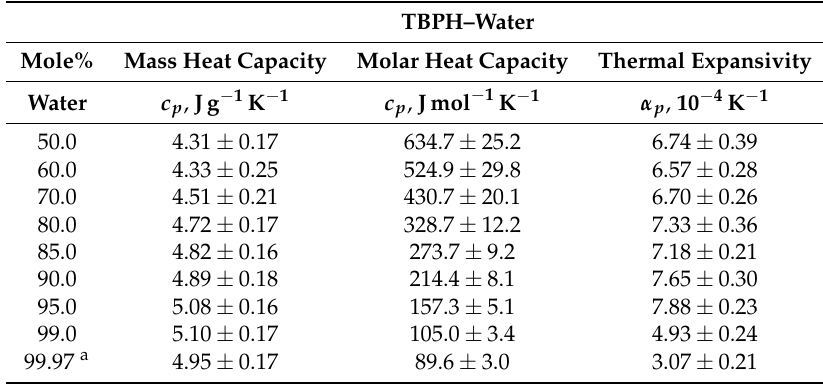
Figure 15. Thermal expansivity ( α p ) constant for TBPH–water and TBPCl–water mixtures at p = 1atm and T = 300K as a function of water concentration. Table 2. Heat capacities and thermal